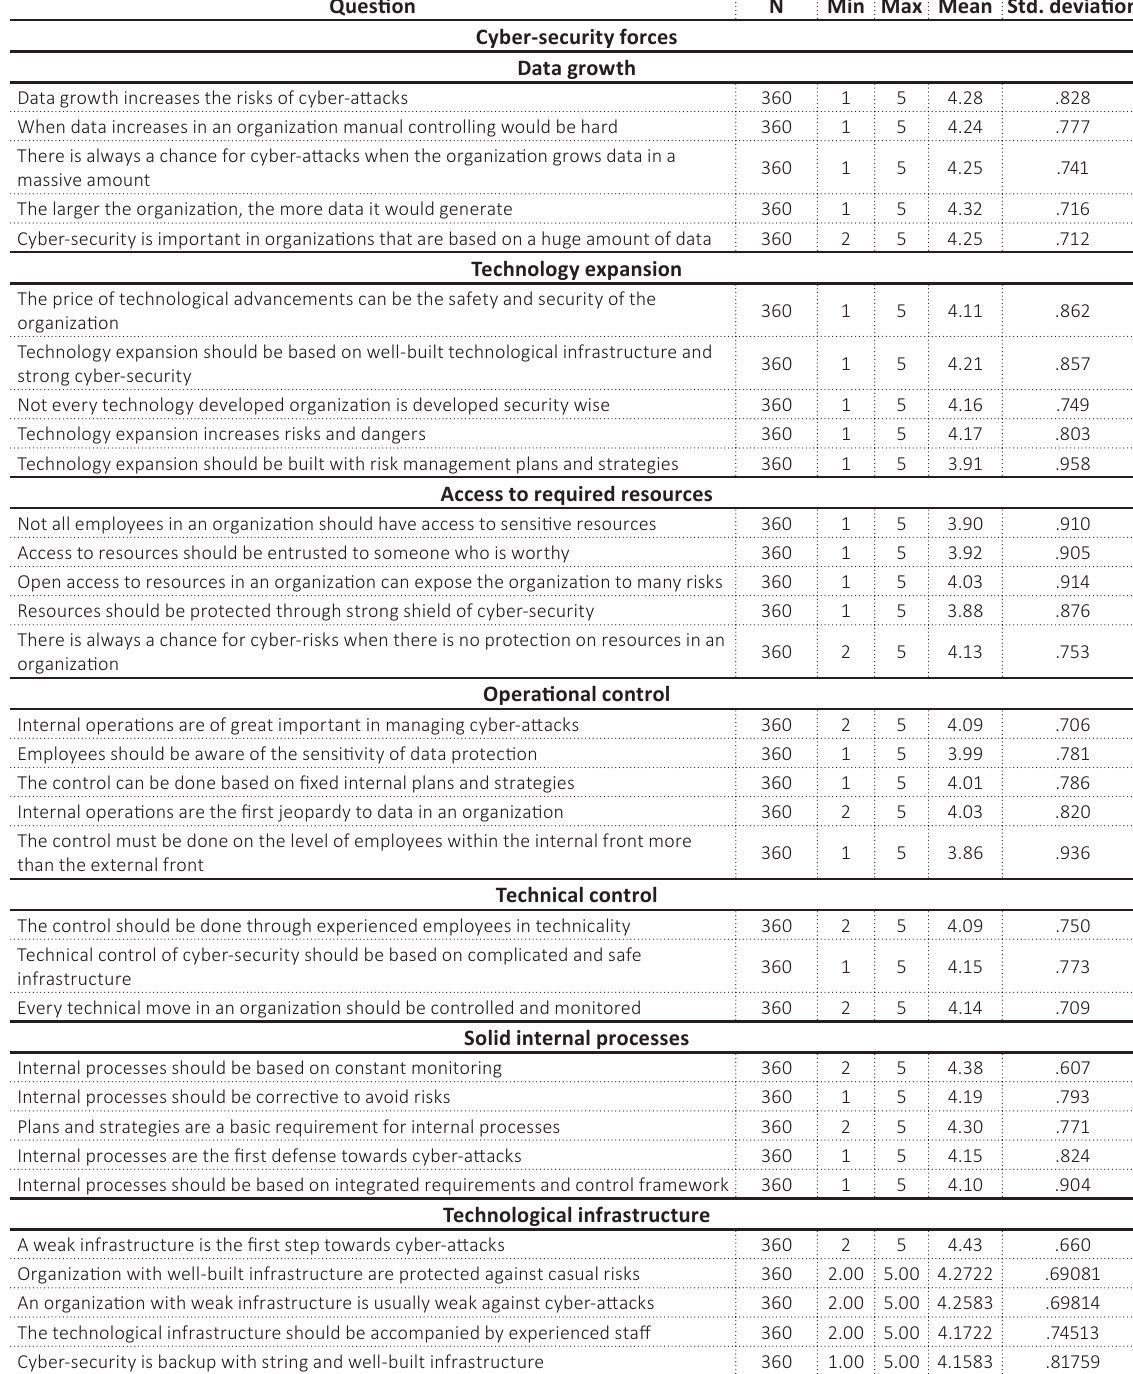
Table 5. Descriptive